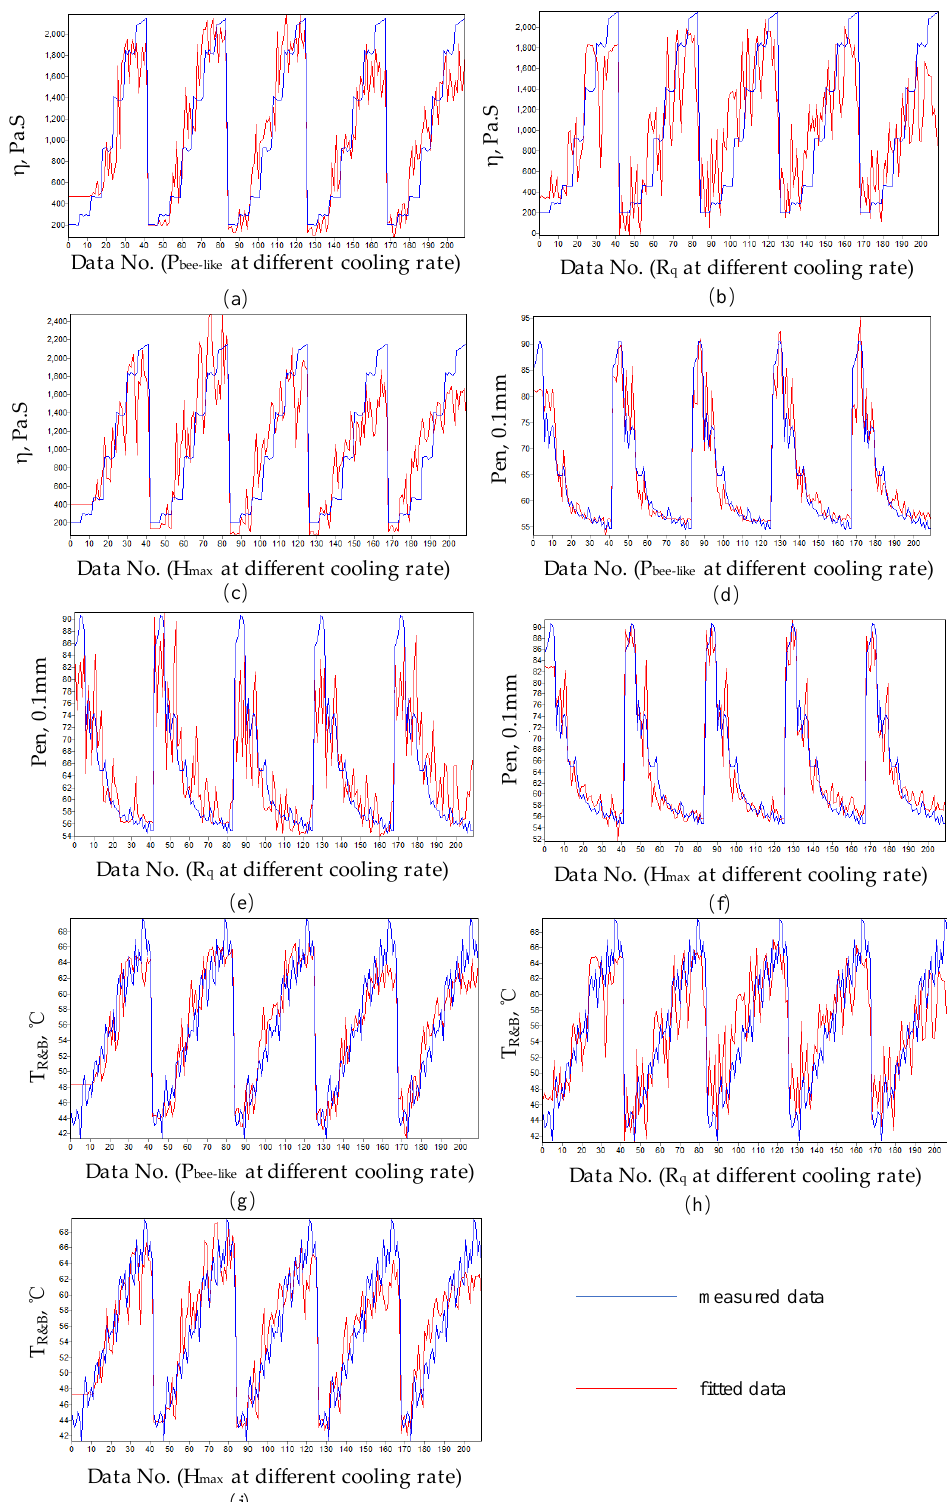
Figure 9. Fitting effect. ( a ) Equation (6); ( b ) Equation (7); ( c ) Equation (8); ( d ) Equation (9); ( e ) Equation (10); ( f ) Equation (11); ( g ) Equation (12); ( h ) Equation (13); ( i ) Equation (14).